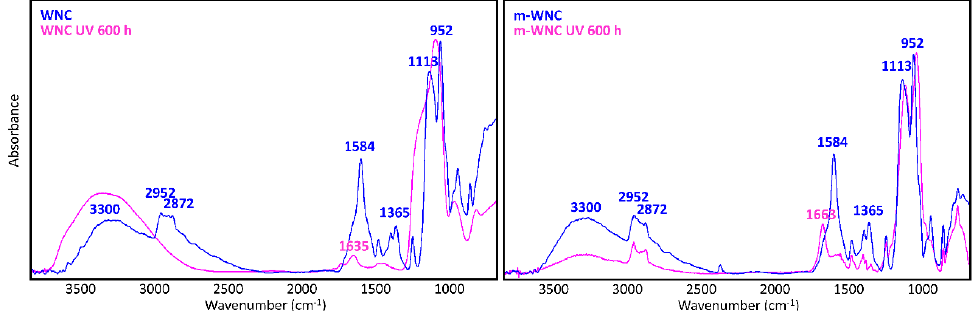
Figure 5. μ -FTIR spectra (ATR mode) of WNC and m-WNC films on glass slides before and after UV ageing for 600 h.